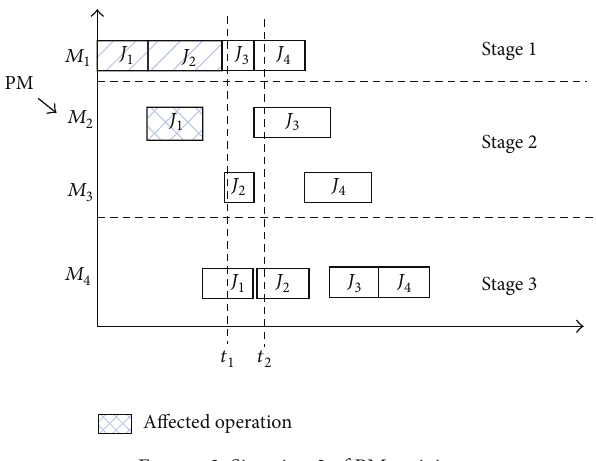
Figure 3: Situation 2 of PM